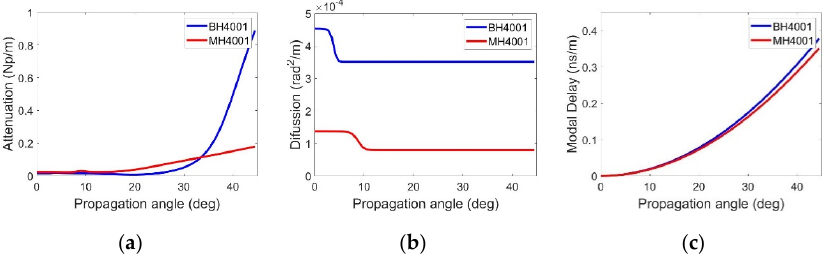
Figure 3. Plastic optical fiber characteristic functions as a function of the propagation angle. ( a ) Attenuation, ( b ) diffusion, and ( c ) group delay.